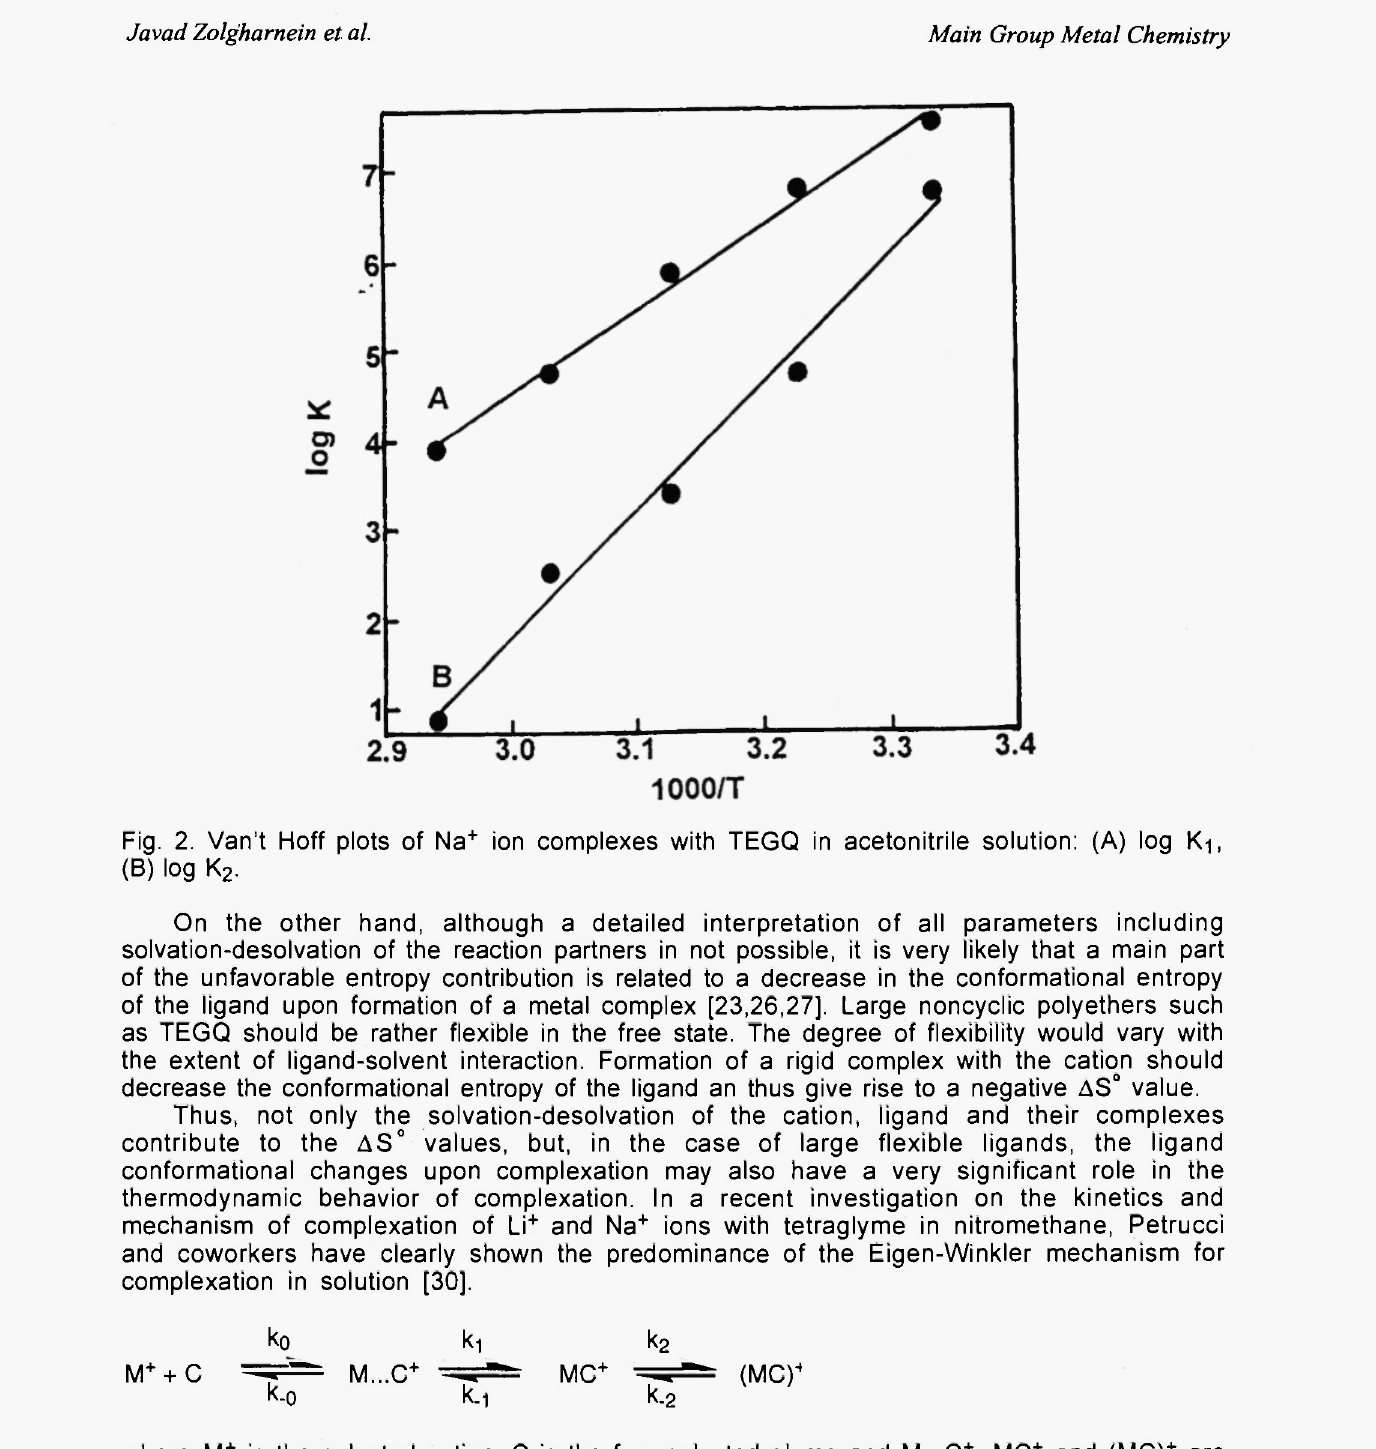
Fig. 2. Van't Hoff plots of Na + ion complexes with TEGQ in acetonitrile solution: (A) log K-|, (B) log K 2